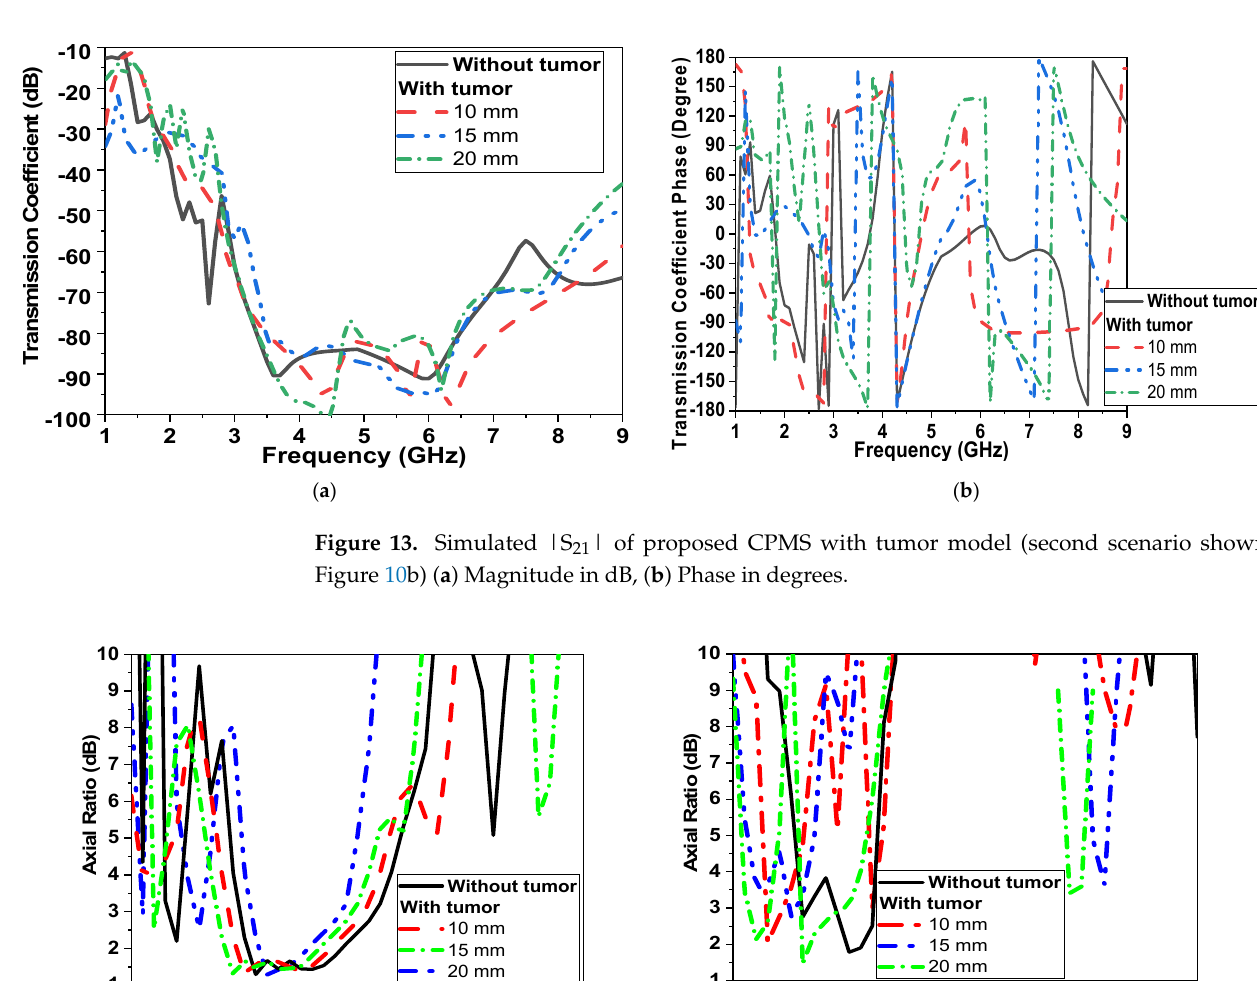
Figure 12, Simulated |S 11 | of the proposed CPMS sensor with tumor model (second scenario shown in Figure 10b) ( a ) Magnitude in dB, ( b ) Phase in degrees.